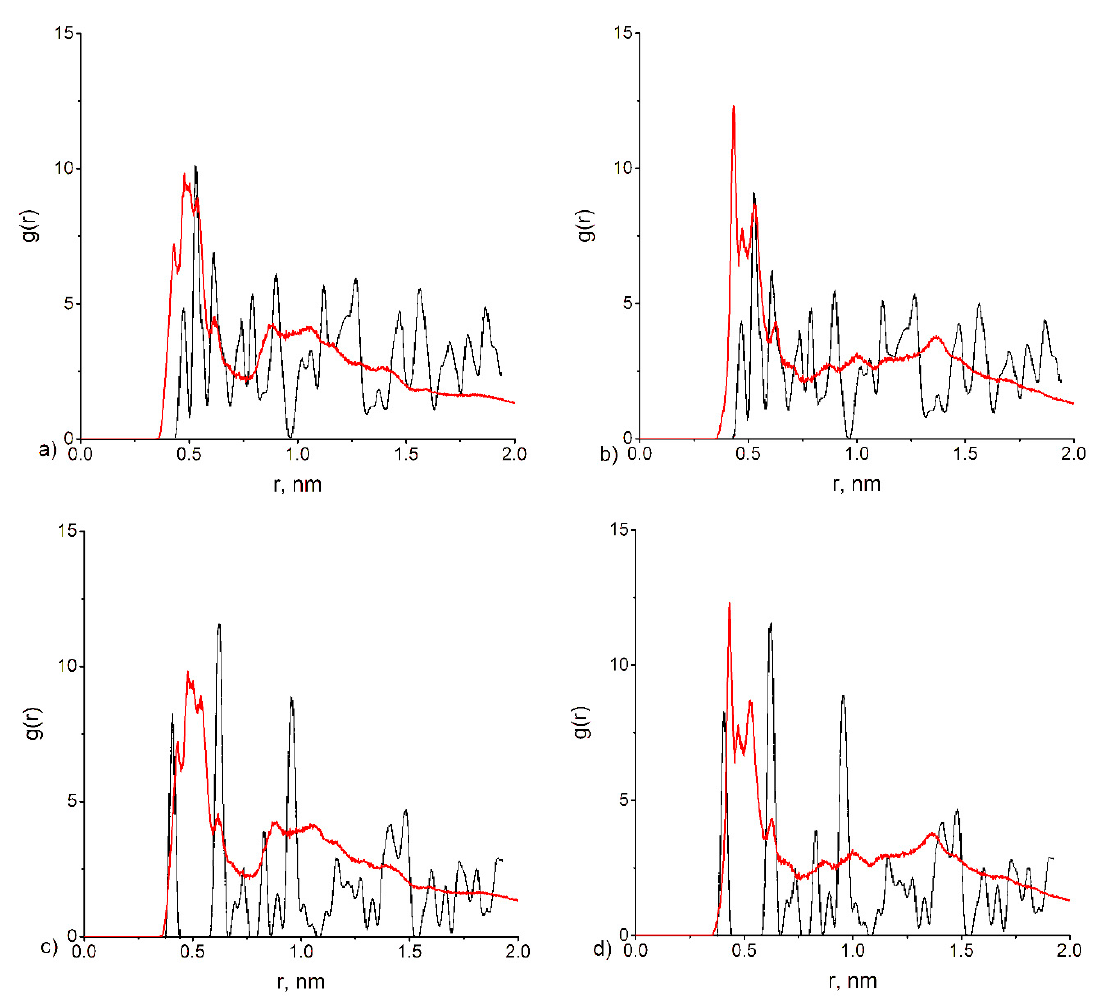
Figure 12. The pair distribution functions obtained from our simulations compared to the distribution obtained for calcium tri-hydrated and di-hydrated oxalates extracted from [75]. Comparison between calcium oxalate tri-hydrate (COT) and ( a ) PASA, ( b ) PGA. Comparison between calcium oxalate di-hydrate (COD) and ( c ) PASA, ( d ) PGA.